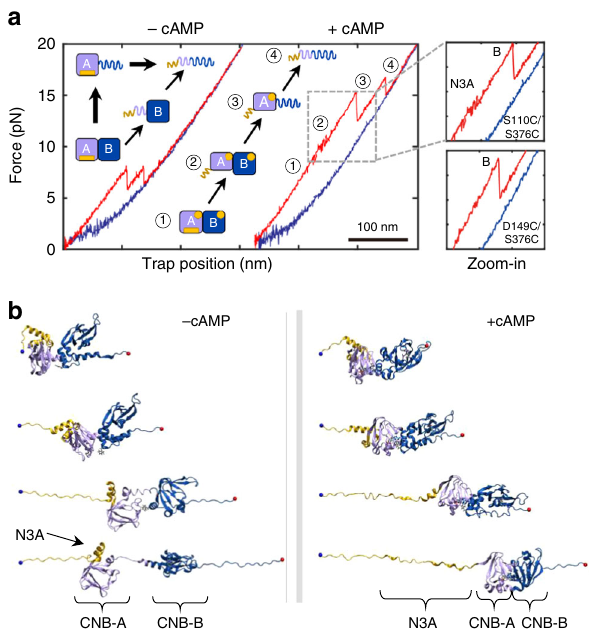
Fig. 3 Dual unfolding pathways of PKA regulatory subunit depending on cAMP occupancy. a Force-extension curve for the cAMP-free (left) and cAMP-bound (right) regulatory subunit (type-III construct). The cartoon represents the structural transitions occurring during the unfolding trajectory in apo- and cAMP-bound states. Zoomed-in are the unfolding trajectories of type-III constructs S110C/S376C and D149C/S376C bound to cAMP. A detailed analysis of the forces for each unfolding transition refer to Supplementary Information and Supplementary Table 4. b Representative structures from cluster analysis along the SMD trajectories of the cAMP-bound (left) and apo (right) regulatory subunit. Yellow: N3A motif; Purple: CNB-A; Dark blue: CNB-B domain